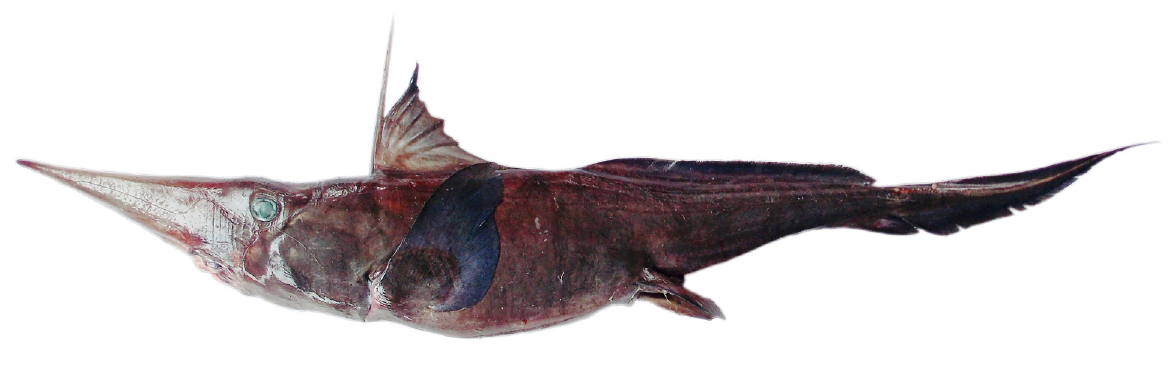
Fig. 6. Dorsal lateral view of Echinorhinus brucus from Andaman waters